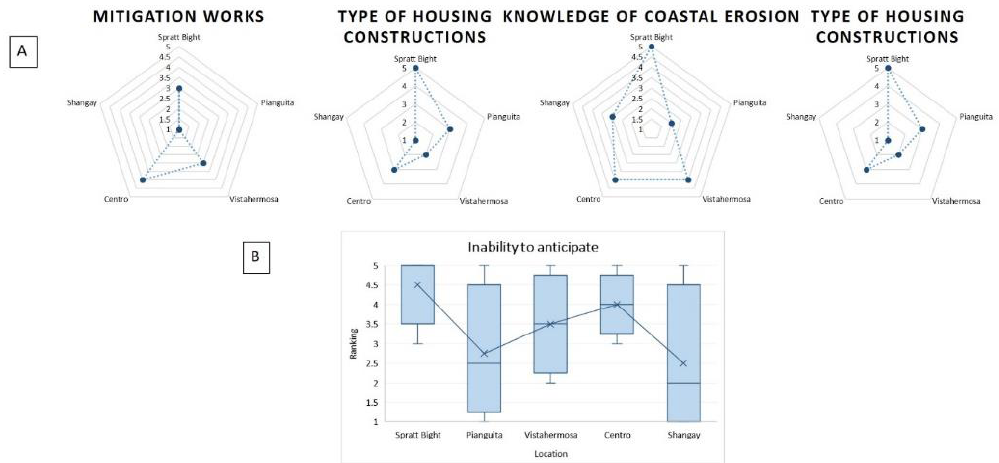
Figure 14. ( A ) Ranking of four variables representing inability to anticipate for two study areas (and five villages): San Andrés, Caribbean Coast (Spratt Bight) and La Bocana, Pacific Coast (Pianguita, Vistahermosa, Centro, Shangay) of Colombia. ( B ) Minimum and maximum values of inability to anticipate for each village and average rank. Results are shown by ranking, given that units of analysis are rank levels and not segments, as was the case for